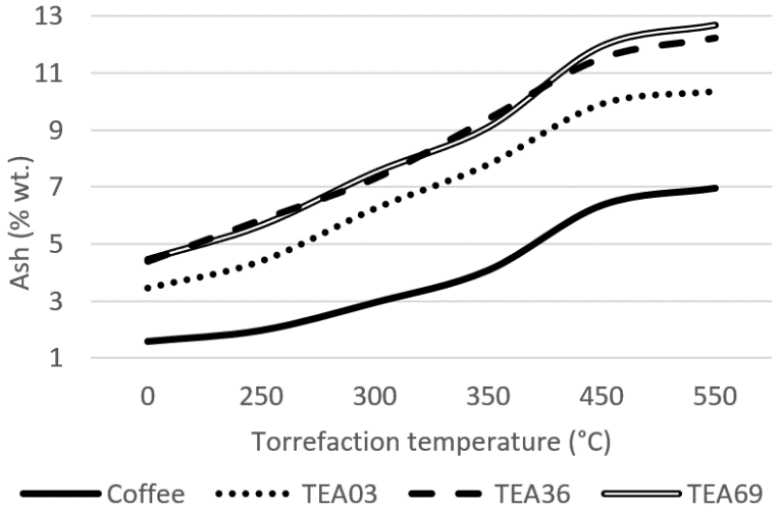
Figure 4. Ash share of the material.